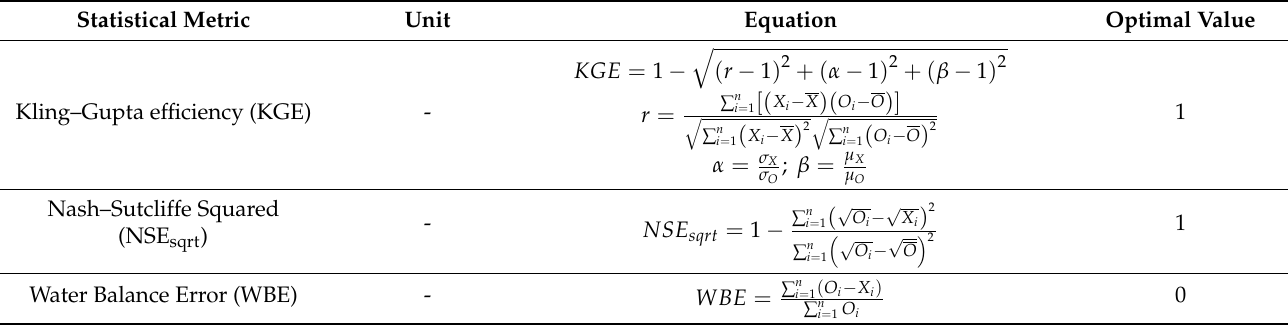
Table 3. Statistical metrics and their corresponding equations used for evaluating the hydrological performance of GR2M model.